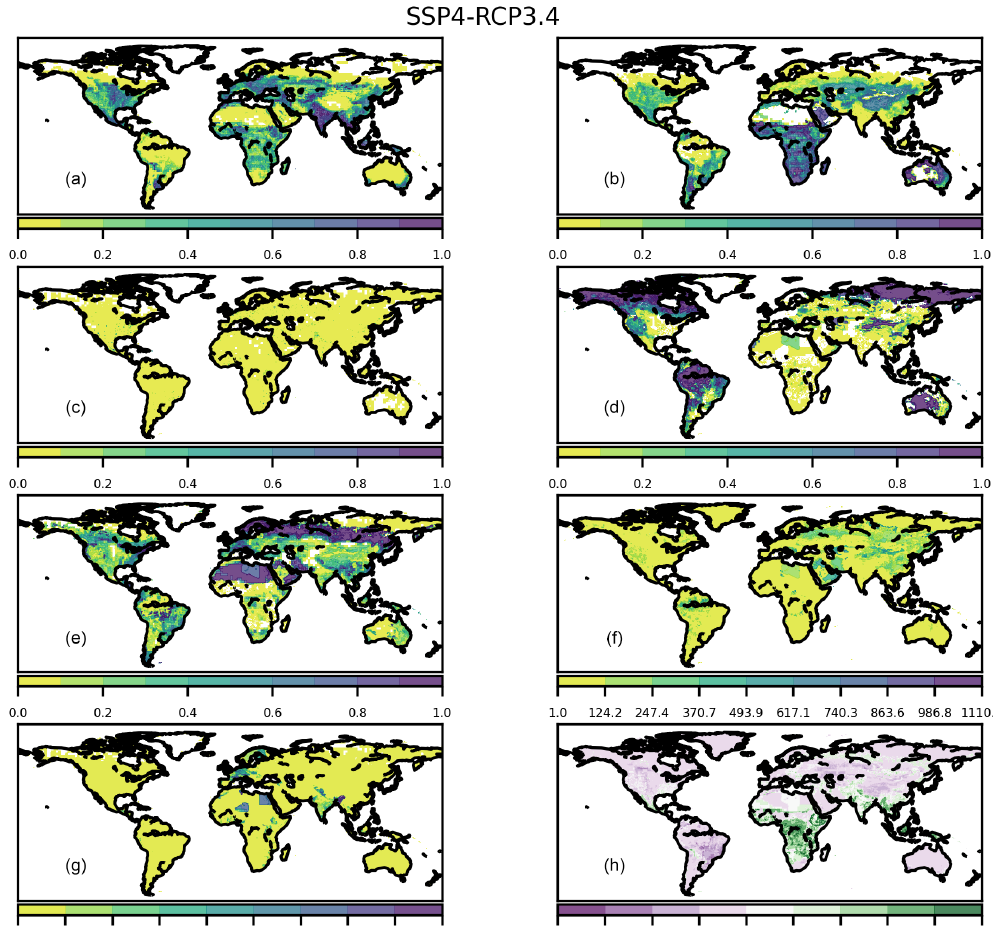
Figure A2. Maps for the year 2100 for the SSP4-RCP3.4 scenario showing the following: (a) the fraction of each grid cell occupied by cropland; (b) the fraction of each grid cell occupied by pasture; (c) the fraction of each grid cell occupied by urban land; (d) the fraction of each grid cell occupied by primary vegetation; (e) the fraction of each grid cell occupied by secondary vegetation; (f) the mean age (in years) of secondary lands in each half-degree grid cell; (g) the mean gross transitions (km 2 yr − 1 ) over a 20-year interval for each grid cell; and (h) the mean net transitions (km 2 yr − 1 ) over a 20-year interval for each grid